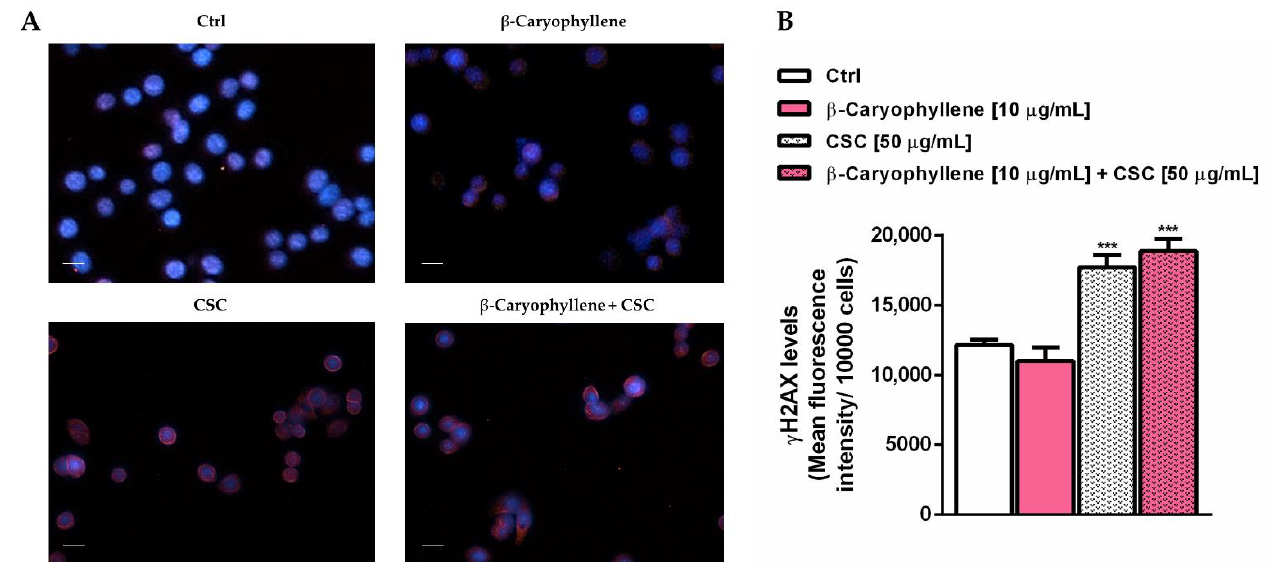
Figure 9. Levels of γ H2AX induced by cigarette smoke condensate (CSC) and β -caryophyllene in MDA-MB-468 cancer cells after 24 h exposure. ( A ) Representative images of cells stained by Alexa Fluor ® 647 anti-gamma H2A.X (phospho S139) antibody and Hoechst 33,258 dye. ( B ) Data are displayed as mean ± SE of at least three independent experiments with at least two technical replicates ( n = 6). *** p < 0.001, significant lowering of cell viability with respect to the control (ANOVA + Dunnett’s multiple comparison post -hoc test). Scal e bars = 20 μm .